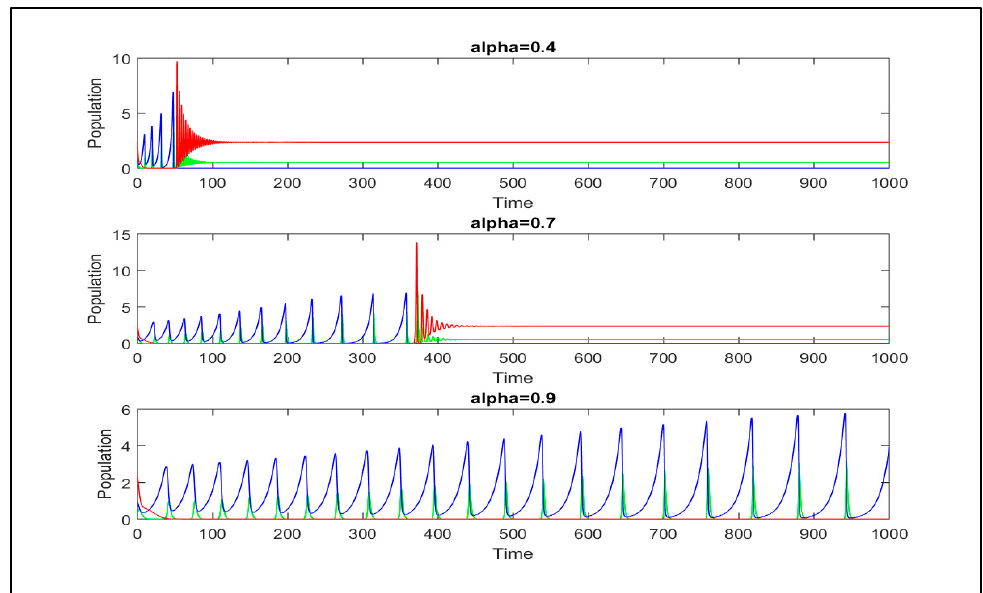
Figure 5. Time series solution at different values of α .